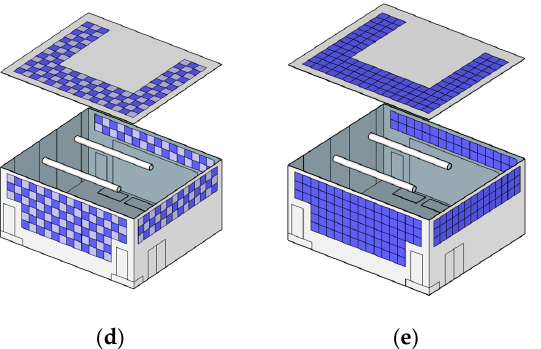
Figure 5. Proposed design solutions for the acoustic treatment in meeting room 1, for a total number of panels equal to 277. ( a ) 277 panels, absorbers only, are placed on the ceiling; ( b ) 192 absorber panels are placed on the ceiling and 85 on the rear wall; ( c ) 132 absorbers are placed on the ceiling and 85 on the rear wall, 28 diffusers are placed on the upper part of side wall and 32 find place on the upper part of the front wall; ( d ) as for configuration (c), but with 66 absorbers and 66 diffusers placed on the ceiling and 73 absorbers and 73 diffusers placed on the walls; ( e ) as for configuration (c), but with 132 absorbers placed on the ceiling and 145 placed on the walls.